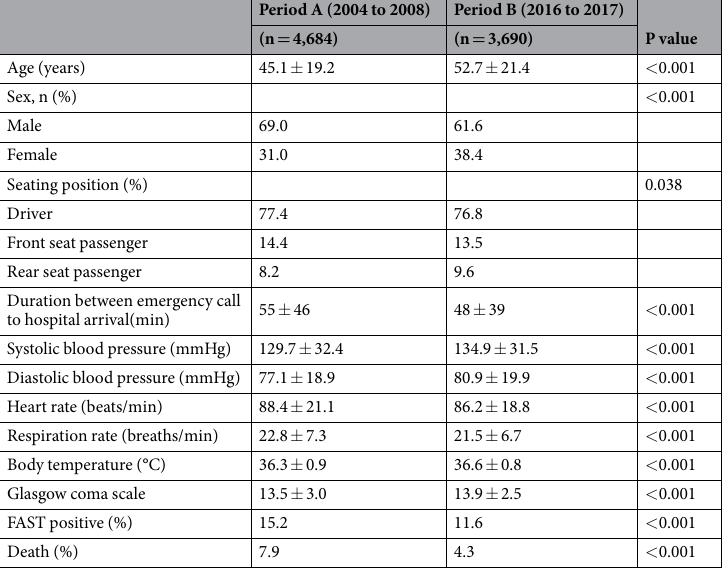
Diastolic blood pressure (mmHg) 77.1 ± 18.9